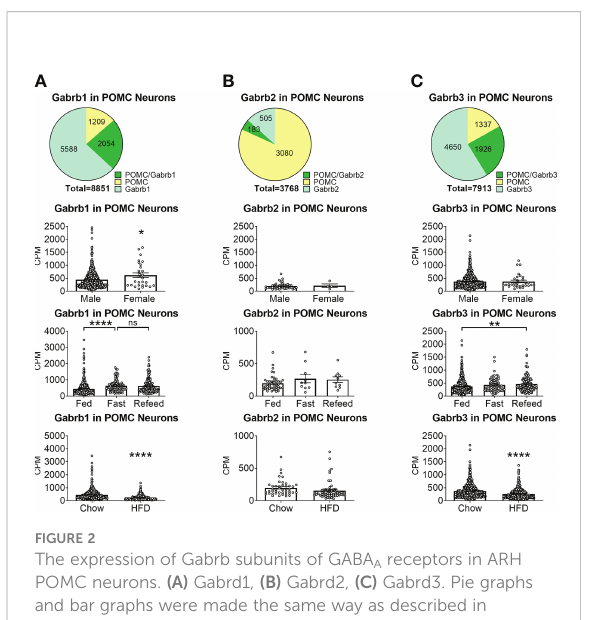
FIGURE 2 The expression of Gabrb subunits of GABA A receptors in ARH POMC neurons. (A) Gabrd1, (B) Gabrd2, (C) Gabrd3. Pie graphs and bar graphs were made the same way as described in Figure 1. ns, not signi fi cant. *, **, **** P < 0.05, 0.01 or 0.0001 in unpaired t-tests.